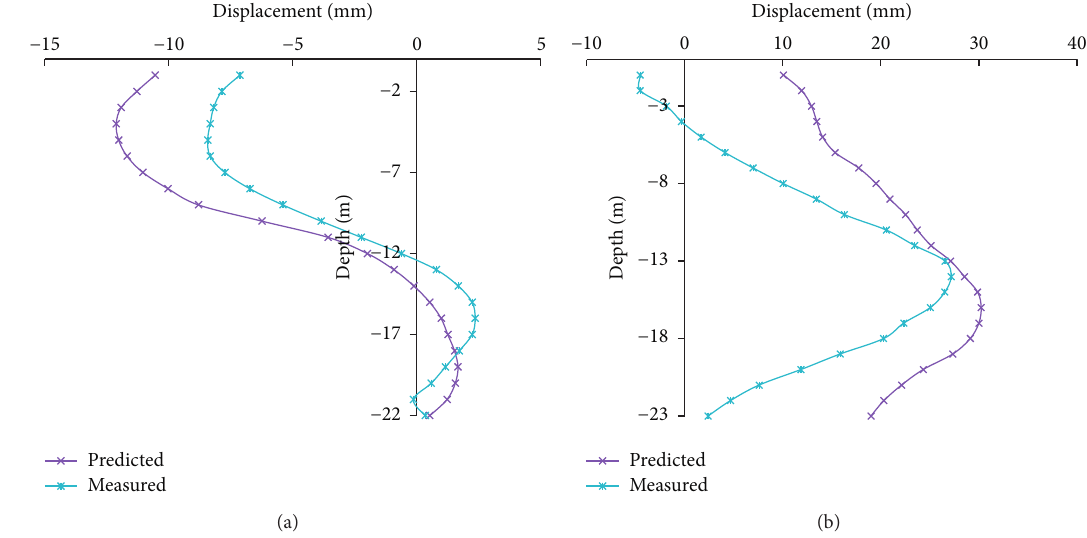
Figure 6: Comparison of the horizontal displacement of the underground diaphragm wall. (a) Horizontal displacement of the underground diaphragm wall adjacent to the existing station. (b) Horizontal displacement of the underground diaphragm wall away from the existing Table 6: The axial force comparison of the internal support under each analysis condition.